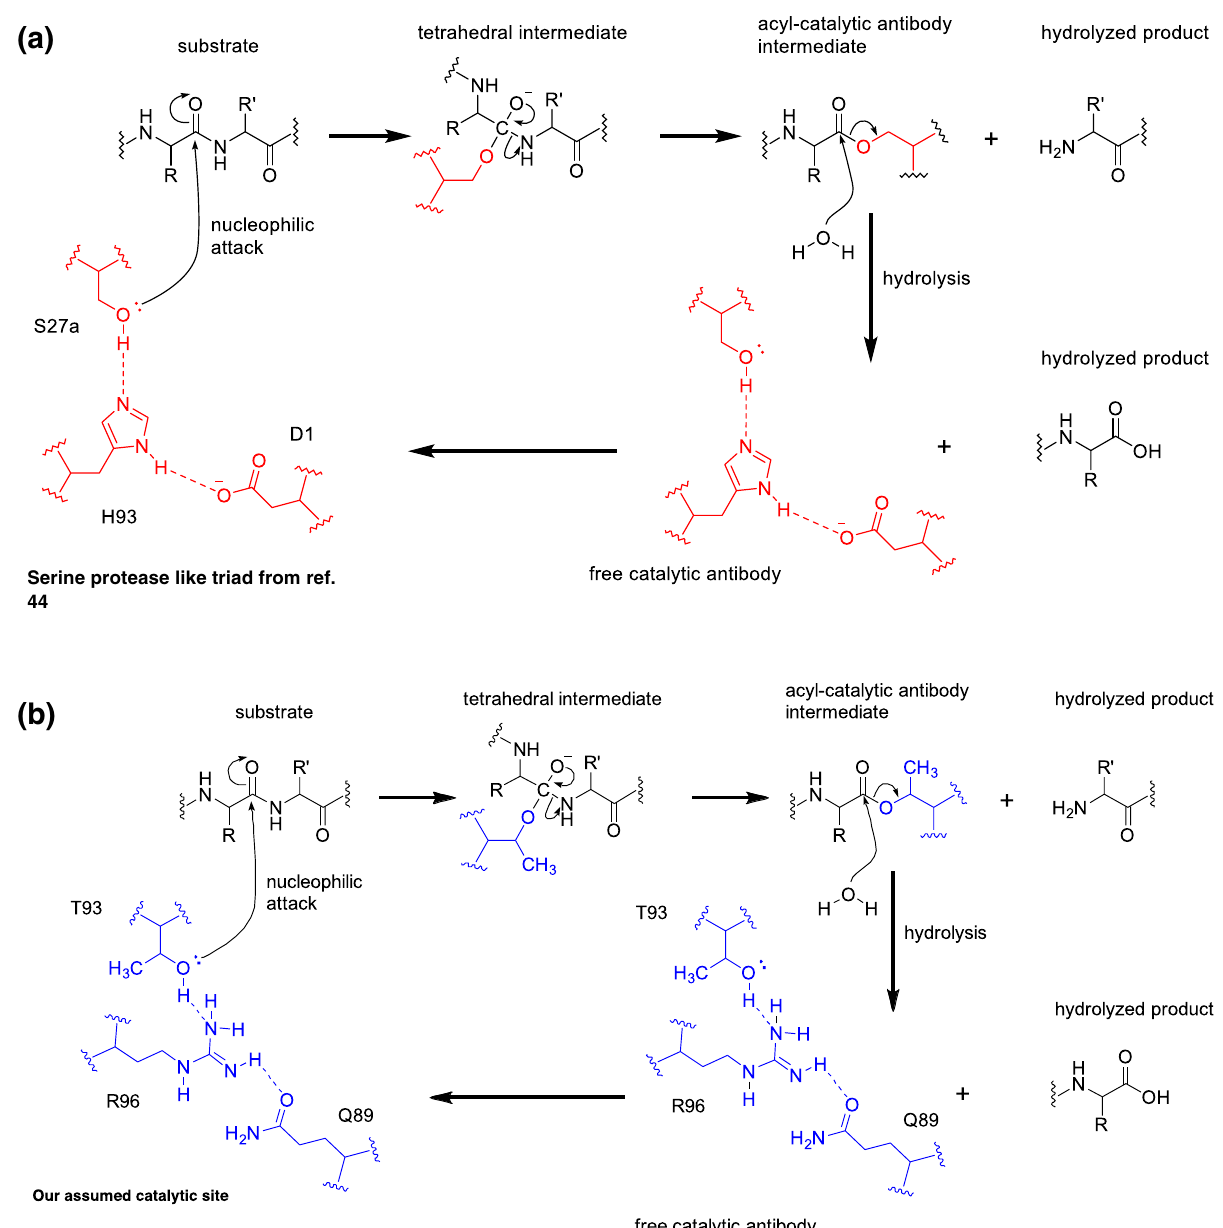
Figure 10. Reaction scheme by serine protease-like triad and catalytic site of H34wt. ( a ) In the case of serine protease-like triad, the hydroxyl group of the catalytic Ser of the catalytic antibody directly initially attacks the cleavable bond. ( b ) In the case of H34wt, similarly, the hydroxyl group of the catalytic Thr of H34wt directly attacks the scissile bond. Then, finally, the deacylation of the acyl catalytic antibody intermediate with water forms a second product and regenerates the free catalytic